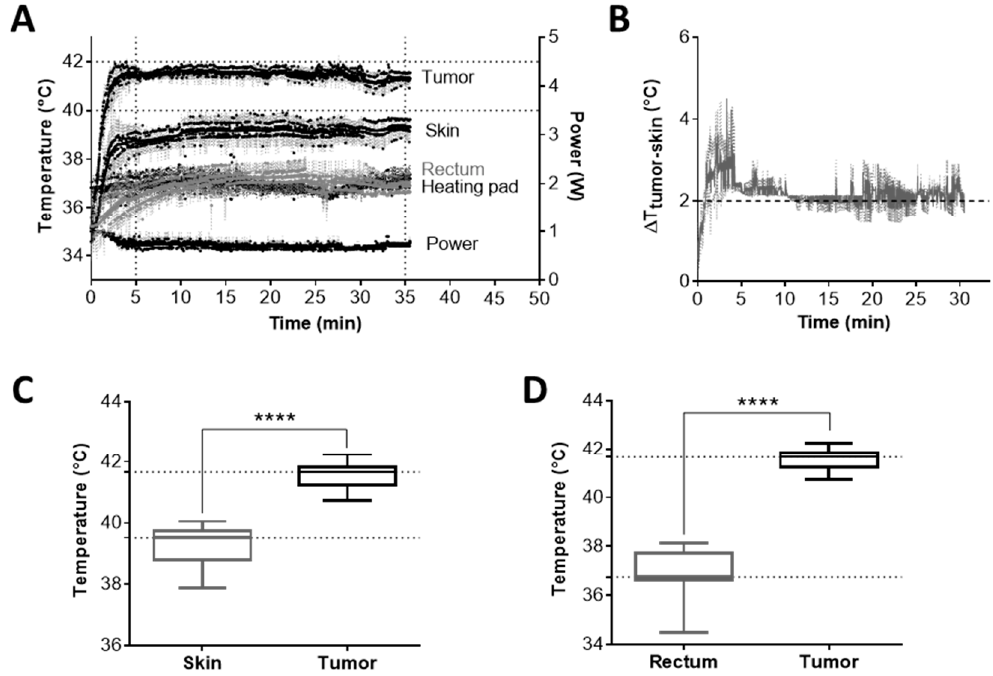
Figure 2. Selective warming of the tumor tissue. ( A ) Temperature curves of the tumor, skin, and rectum during mEHT-treatment ( n = 5). ( B ) Temperature gradient between the tumor core and skin above the tumor ( n = 5). Mean ± SEM. ( C , D ) Temperature of skin ( C ) or rectum ( D ) vs. tumor core during treatment. Average and box and whiskers: min to max, **** p < 0.0001.